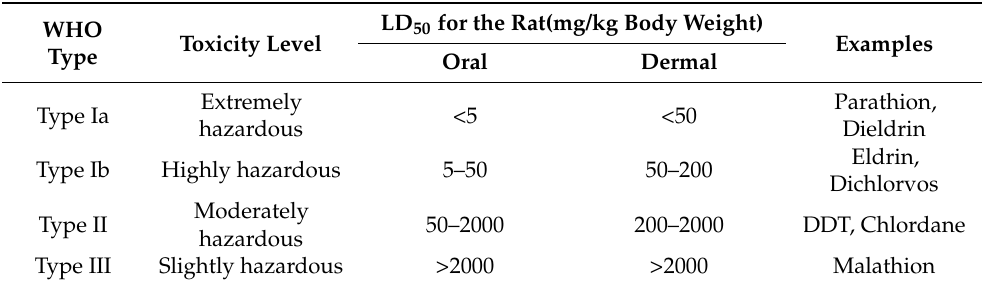
Table 4. Classification according to the toxicity of pesticides set by the World Health Organization (WHO) [61].